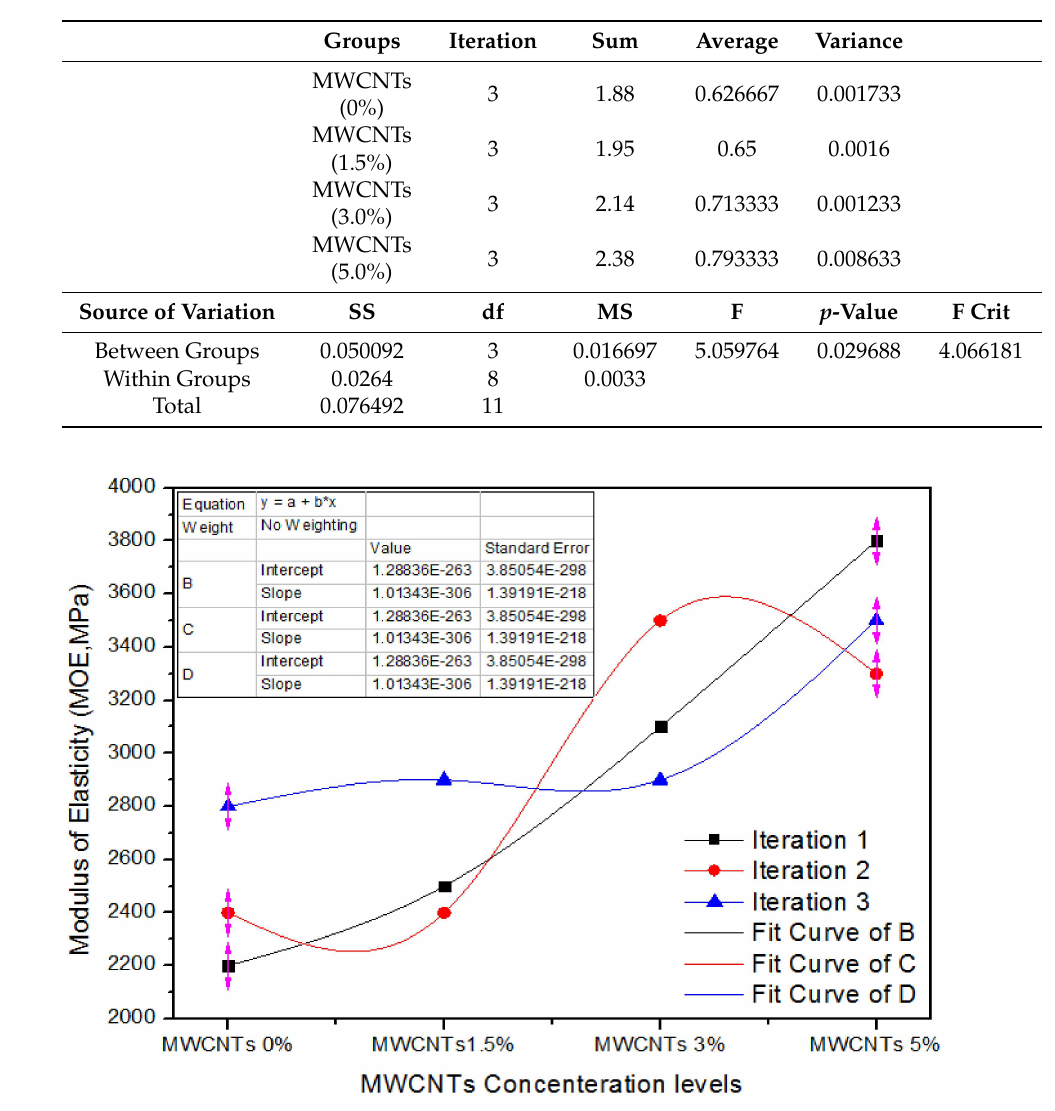
Table 9. Internal bond values of MWCNTs-UF nano-MDF for a number of iterations.